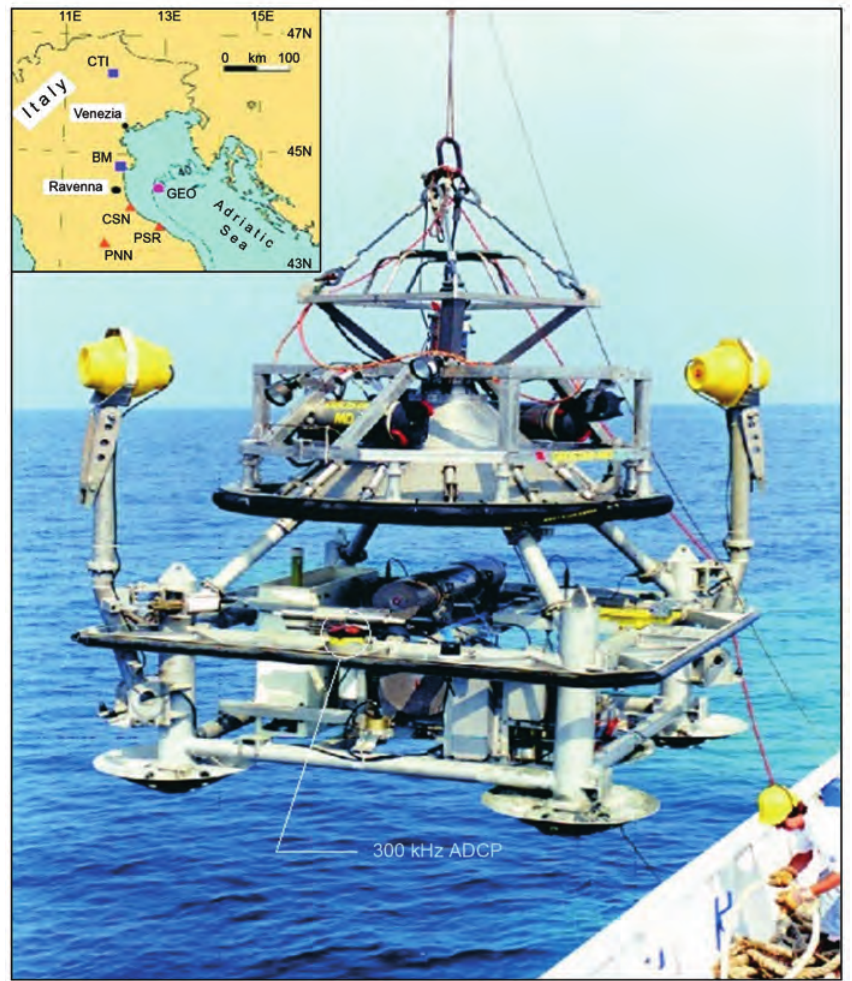
Fig. 1. The GEOSTAR Observatory during deployment. The conical upper part, the base of which is protected by a black rubber fender, is the mobile docker that is removed when the observatory is set on the bottom; it masks the upper part of the docking/undocking tetrahedral armature. Then, the docker is used only for recovery, hence as a fe- male, to clamp the observatory via a pin system set on top of the four inclined tubes. The two vertical arms termi- nated by yellow spheres that contain magnetometers will be lowered on the bottom, i.e. away from the observatory. During the experiment, the ADCP is thus nearly on top of the observatory. Also shown is the deployment